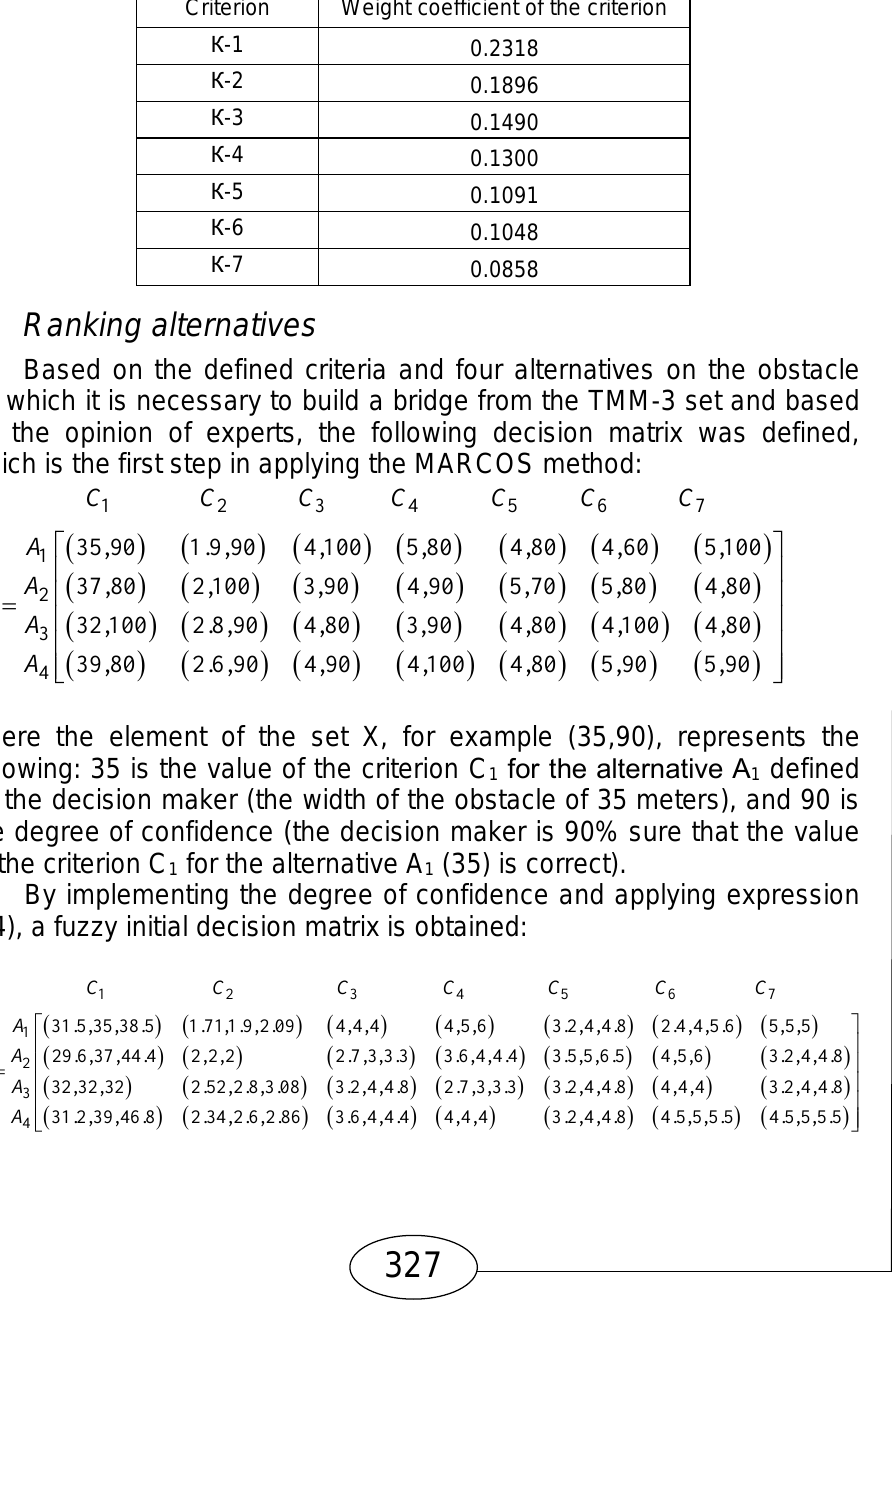
Таблица 1 – Значения весовых коэффициентов критериев Табела 1 – Вредности тежинских коефицијената критеријума